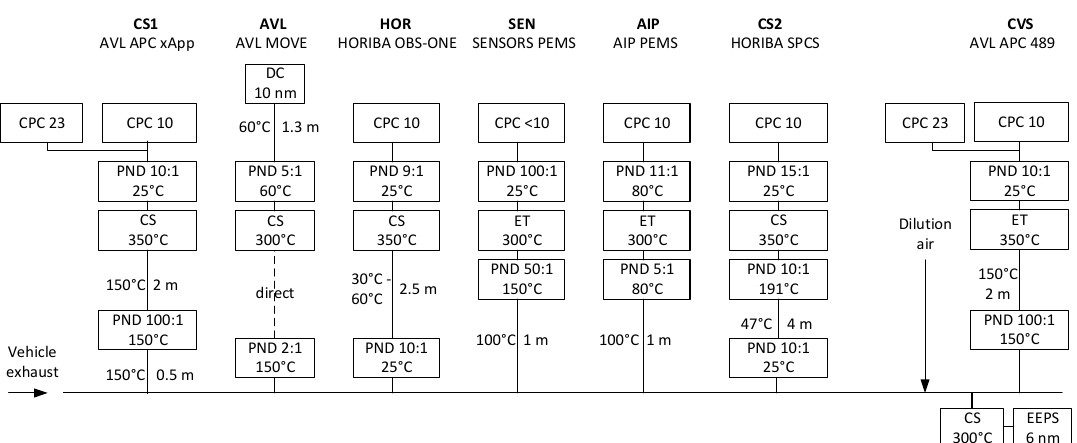
Figure 1. Schematic of the setup. CPC = condensation particle counter; CS = catalytic stripper; DC = diffusion charger; EEPS = engine exhaust particle sizer; ET = evaporation tube; PND = article number diluter.